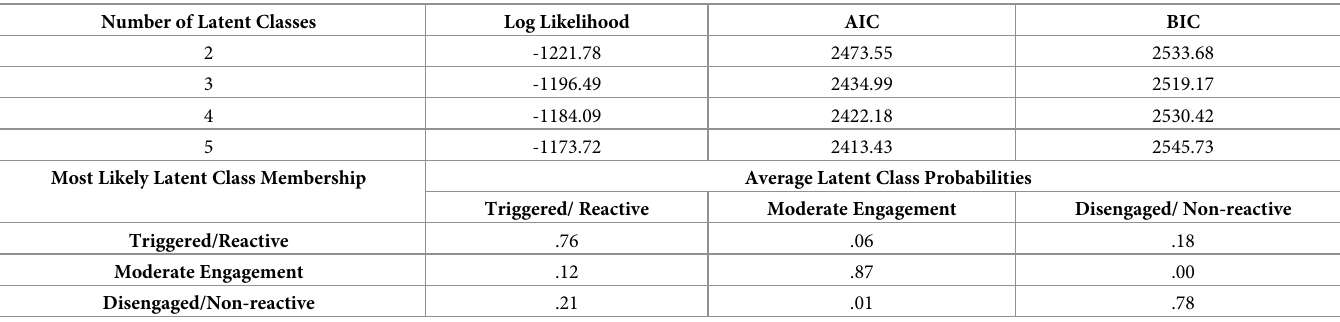
Table 2. Overall model fit indices for different number of latent classes and latent class membership probabilities for the three-class